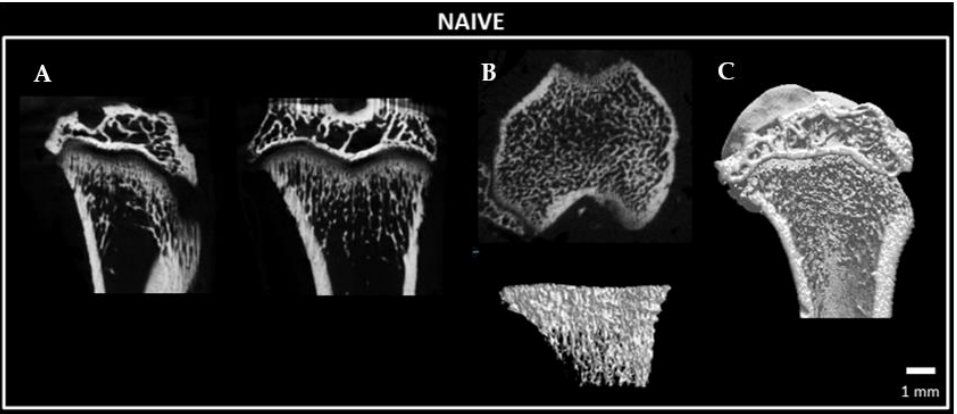
Figure 11. Representative micro-CT images showing trabecular architecture of the tibia bone of a naïve rat. ( A ) Coronal, sagittal and trans-axial sections; ( B ) Three-dimensional trabecular architecture; ( C ) Three-dimensional architecture of the distal tibia bone in coronal view. Scale bar: 1 mm.